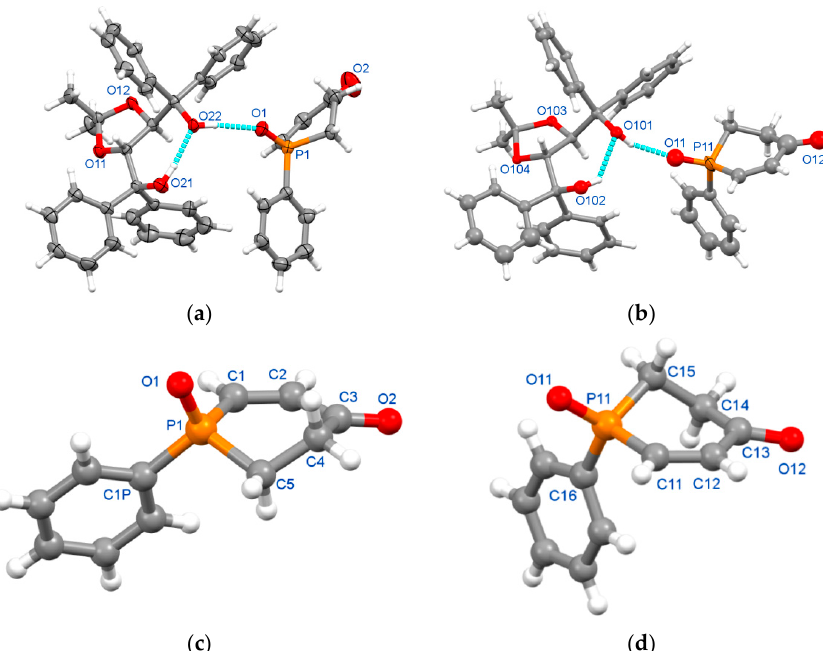
Figure 4. The 1:1 structure of the molecular complexes of ( R , R )-TADDOL with ®- 2 ( a ) and ( S )- 2 ( b ) with thermal ellipsoids set at 50% probability. Perspective view of enantiomeric molecules ®- 2 ( c ) and ( S )- 2 ( d ). Dotted blue lines indicate the O-H…O hydrogen bonds.